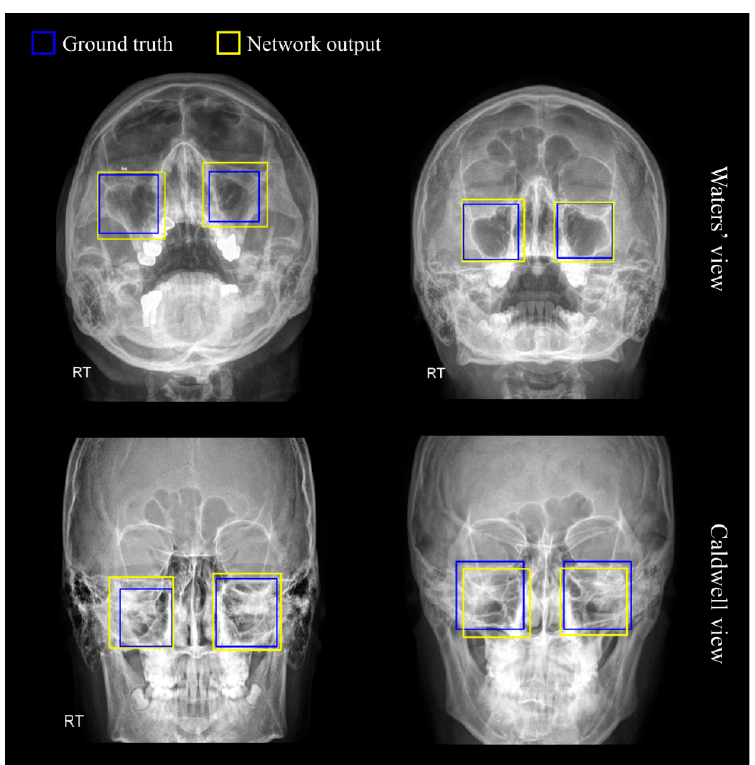
Figure 3. Representative examples of maxillary sinus detection results via RetinaNet. The blue bounding boxes indicate the ground truth and the yellow boxes indicate the prediction results of the neural network.